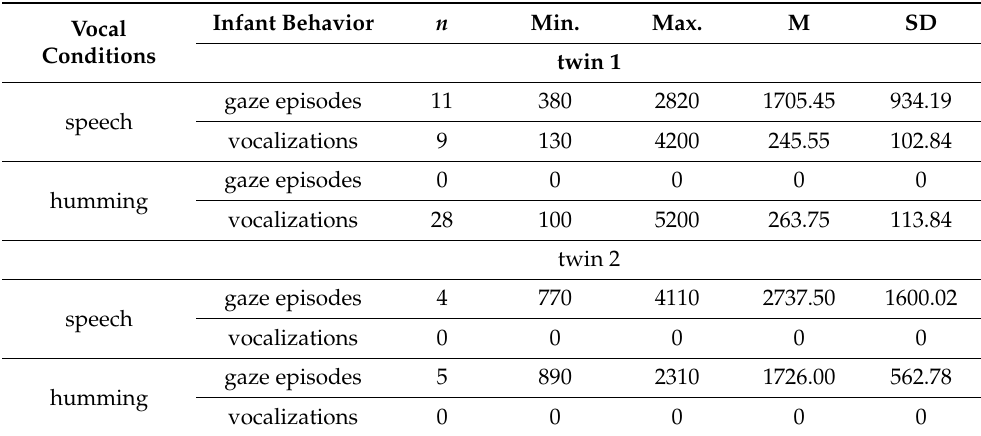
Table 2. Descriptive analysis of the lengths (ms) of infants’ behavior (vocalizations and gaze episodes) in speech and in